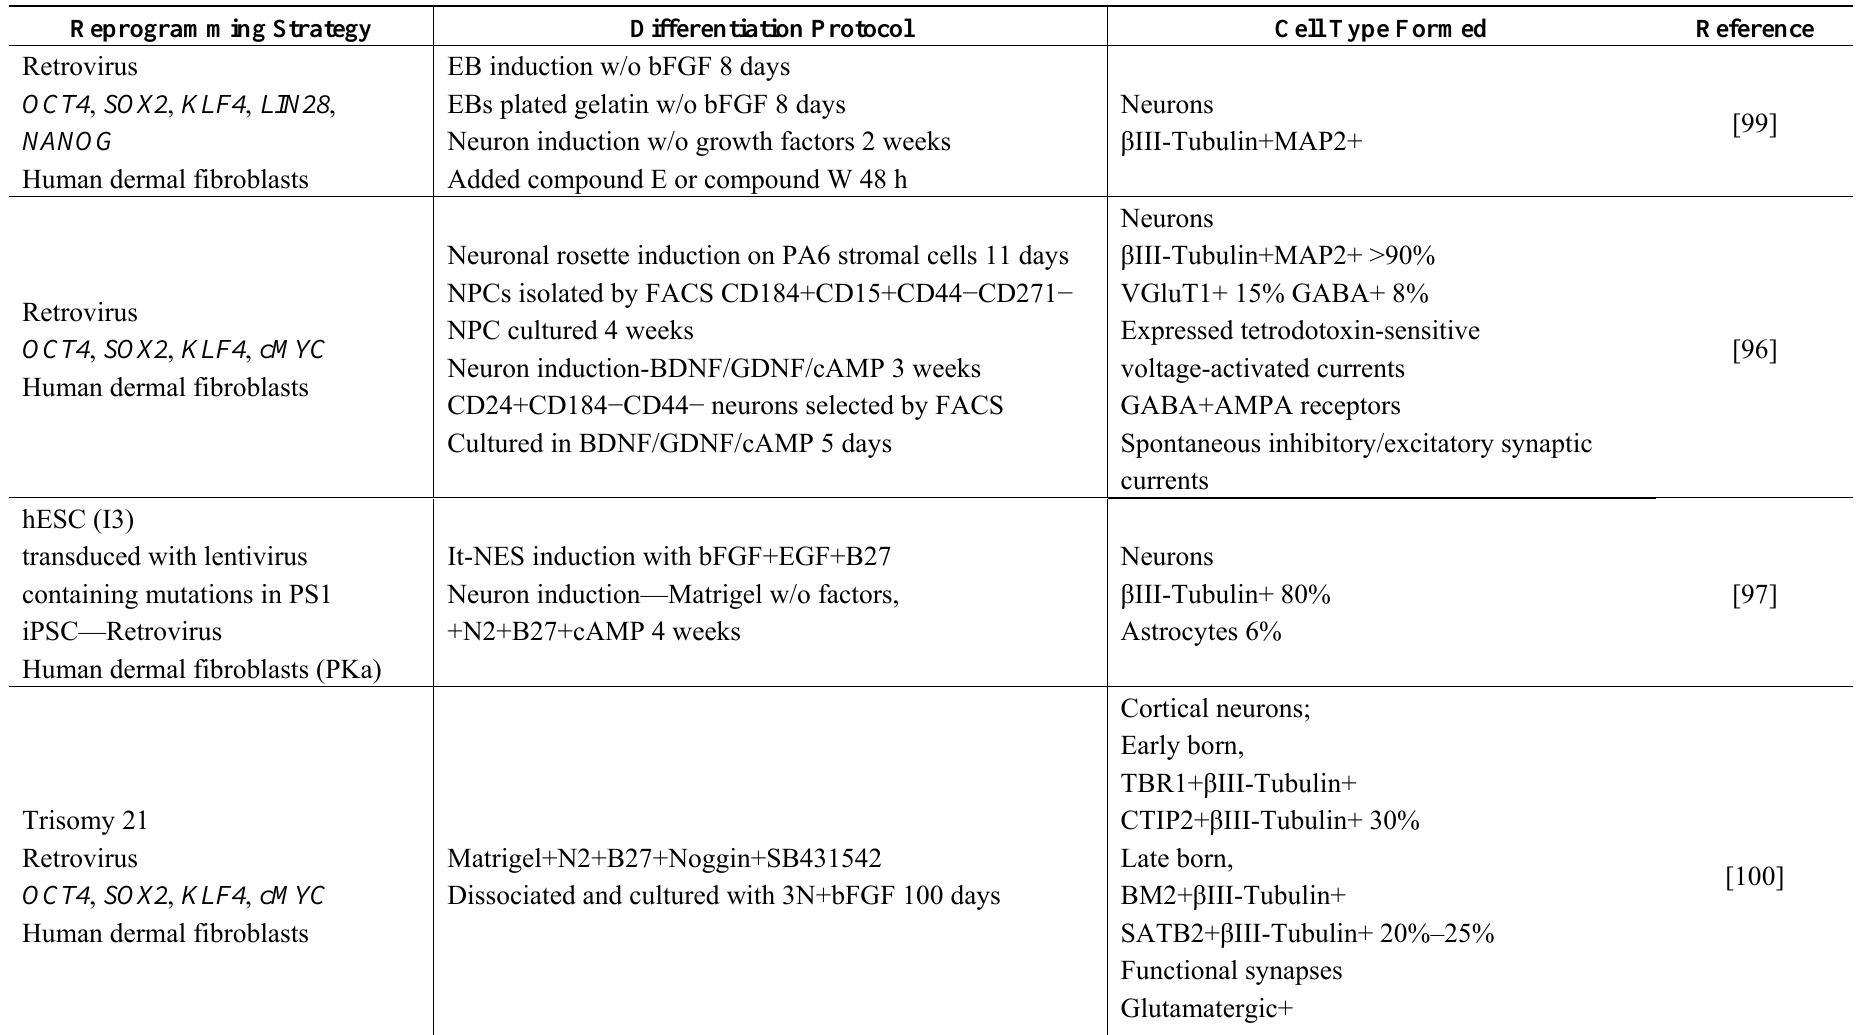
Table 2. Reprogramming and differentiation strategies for induction of induced pluripotent stem cells and their neural